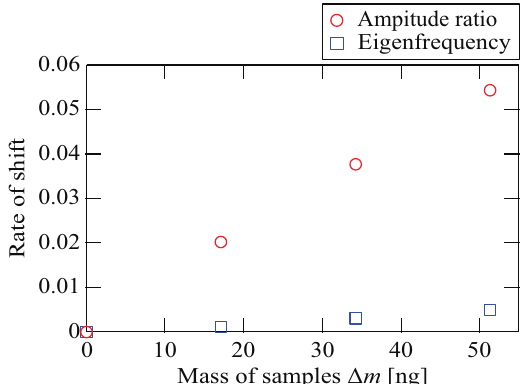
Figure 7. Minute mass measurement result. The horizontal and vertical axes represent the mass of the samples and the rate of shift, respectively. The red circles and the blue squares represent the average rate of shift of the amplitude ratio of the virtually coupled cantilevers and the average rate of shift of the eigenfrequency of the single cantilever, respectively. We set the virtual coupling ratio κ at 0.073 in this experiment. The amplitude ratio of the virtually coupled cantilevers changed in proportion to the added mass. The sensitivity of the virtually coupled cantilevers was over 10 times higher than the conventional method based on the single cantilever’s eigenfrequency